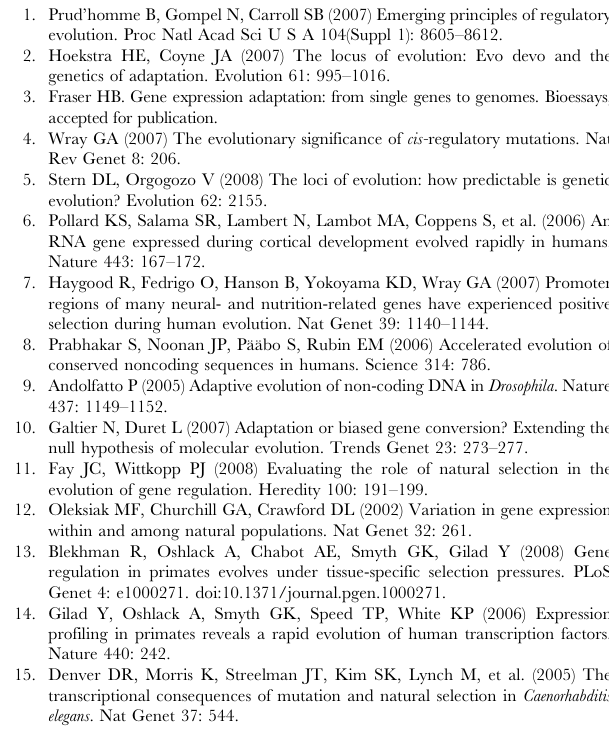
Table S2 All GO categories tested for bias in cis -eQTL directionality, with the hypergeometric p -values based on the bias for each category in each tissue. For further details see the Methods